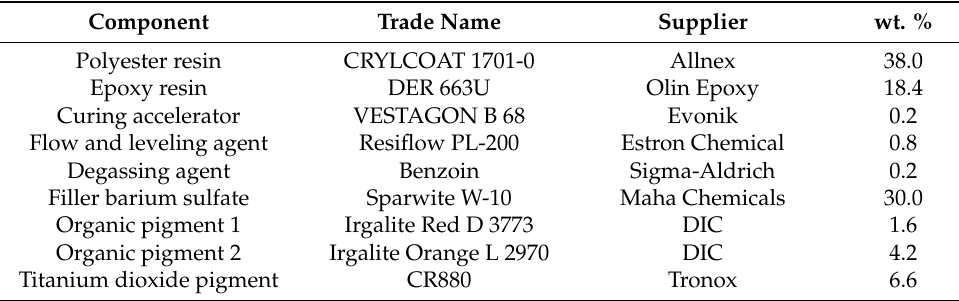
Table 1. Formula 1—orange hybrid powder coating.